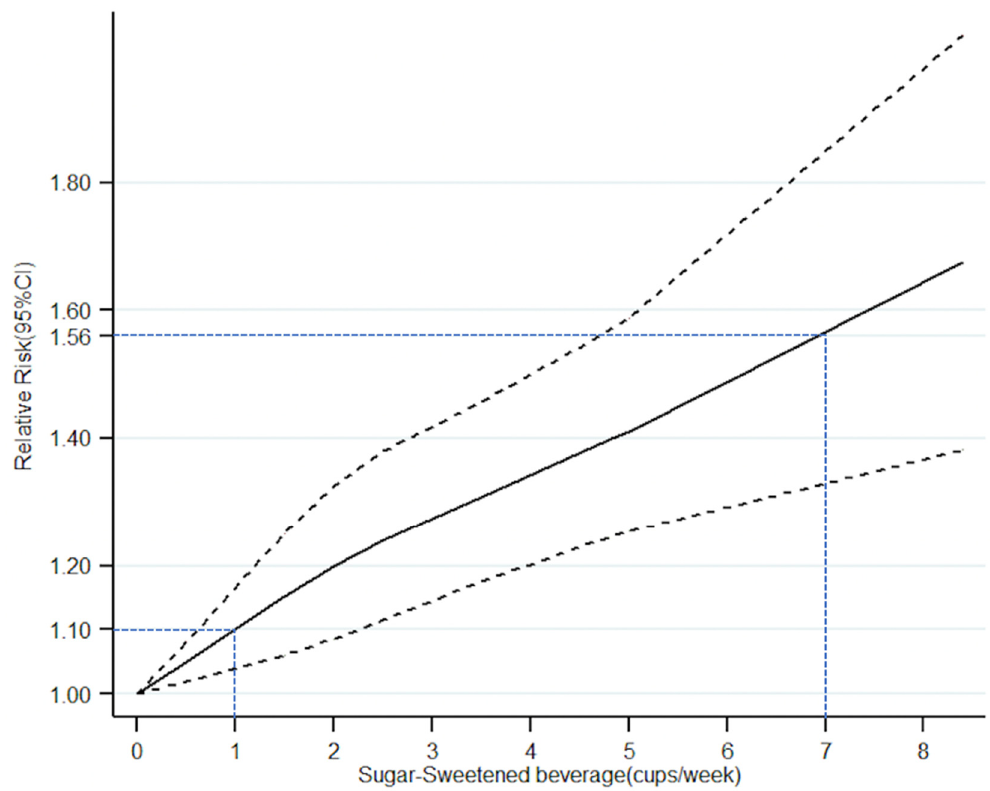
Figure 5. Association between frequency of sugar-sweetened beverages intake (cups/week) and risk of NAFLD obtained by dose–response meta-analyses. Solid line represents the estimated odds ratio and the dot-dashed lines represent the 95% confidence intervals.